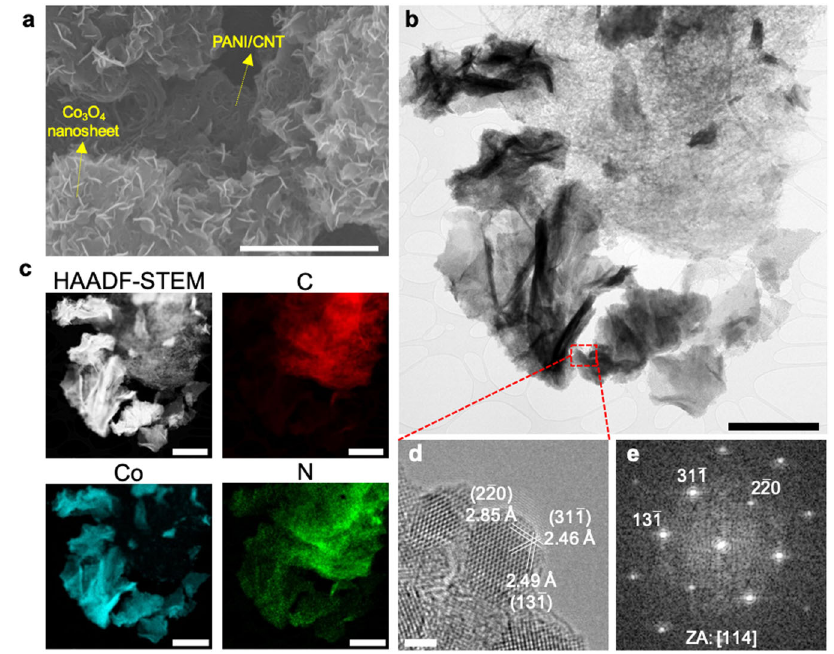
Fig. 3 | Morphology characterization of PANI-CO 3 O 4 /CNT. a A scanning electron microscopy (SEM) image of PANI-Co 3 O 4 /CNT. b A transmission electron micro- scopy (TEM) and c high-angle annular dark- fi eld scanning transmission electron microscopy (HAADF-STEM) image and corresponding energy-dispersive spectro- scopy (EDS) mapping images of PANI-Co 3 O 4 /CNT. Cobalt nanosheets and PANI/